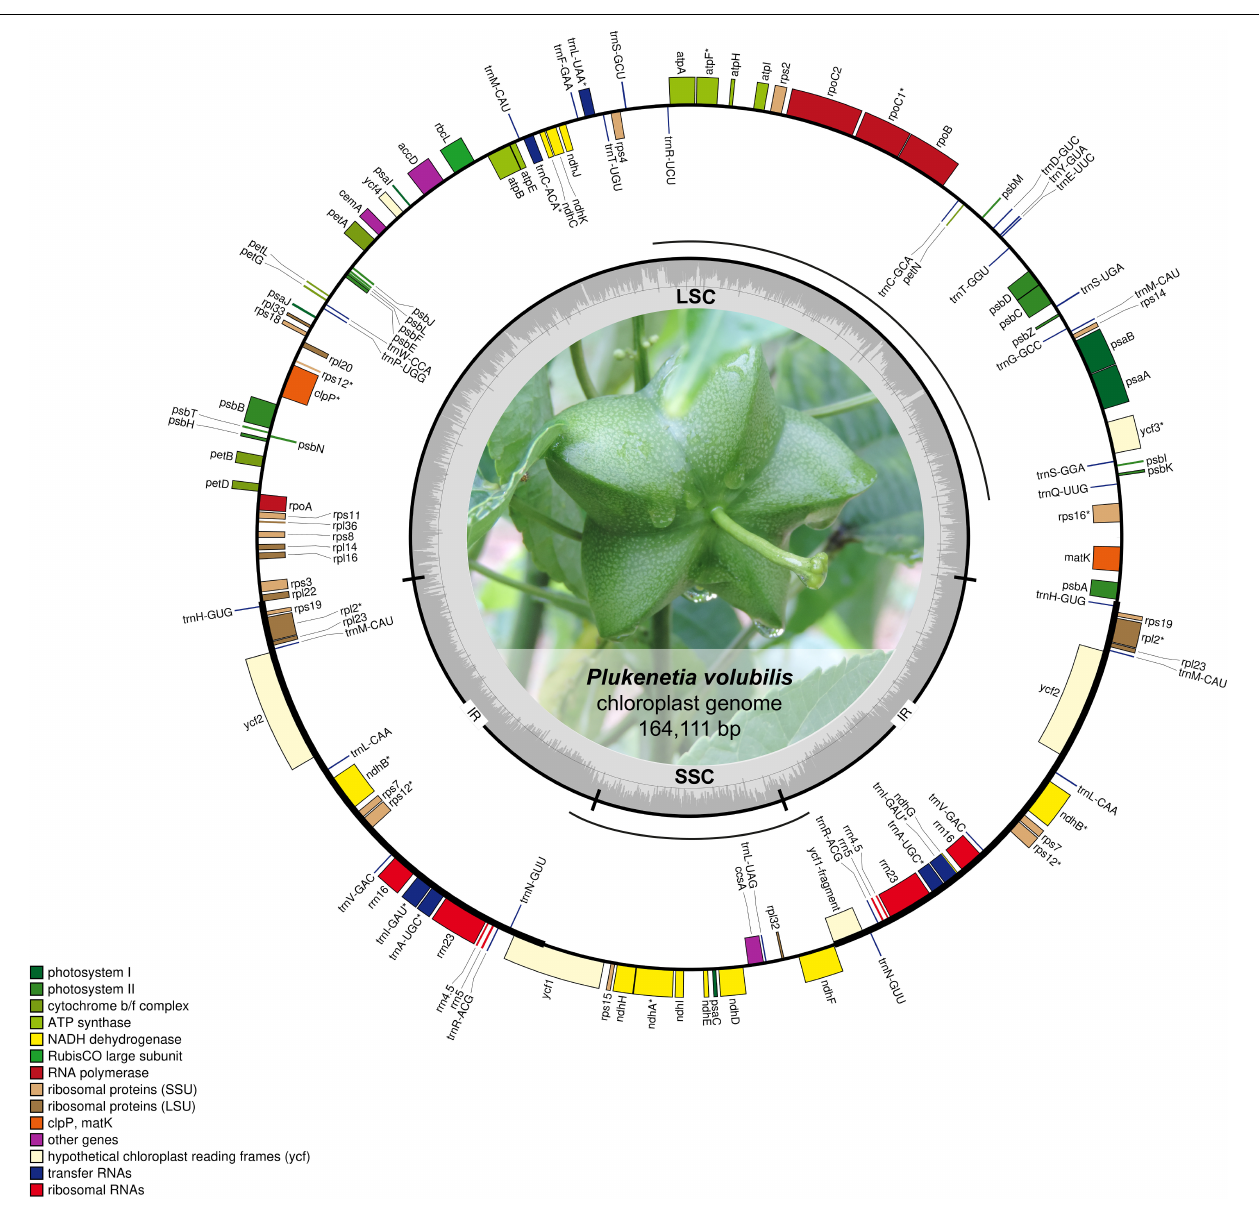
FIGURE 1 | P. volubilis chloroplast genome map. Genes are represented as boxes inside or outside the large circle to indicate clockwise (inside) or counterclockwise (outside) transcription. The color of the gene boxes indicates the functional group to which the gene belongs. IR regions are in a smaller circle, and the inner has the GC content across the genome. LSC, large single-copy region; SSC, small single-copy region. Intron-containing genes are marked with an asterisk (“*”). Inversion regions are represented as discontinuous lines between the two circles.